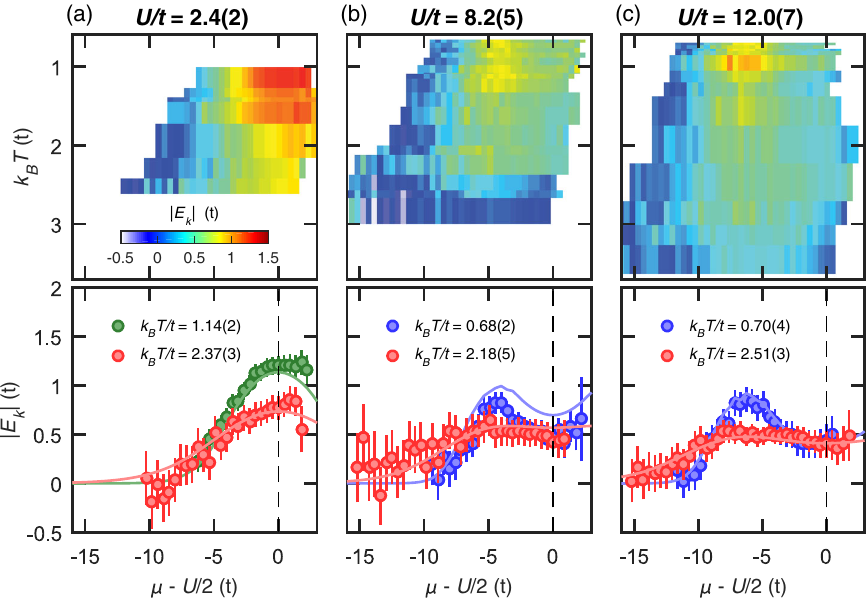
FIG. 4. Kinetic energy versus chemical potential and temperature. The top row shows in color code the complete kinetic energy data set, and the bottom row shows cuts at selected temperatures together with the corresponding NLCE theory (solid lines). While the atoms are maximally delocalized for weak interactions, for strong interactions the delocalization is only reduced, but not fully suppressed. Error bars display the statistical measurement uncertainty; see